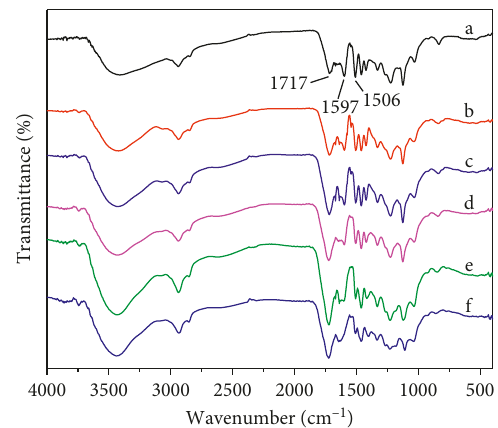
Figure 4: The FT-IR spectrum of different kinds of LPCAs.